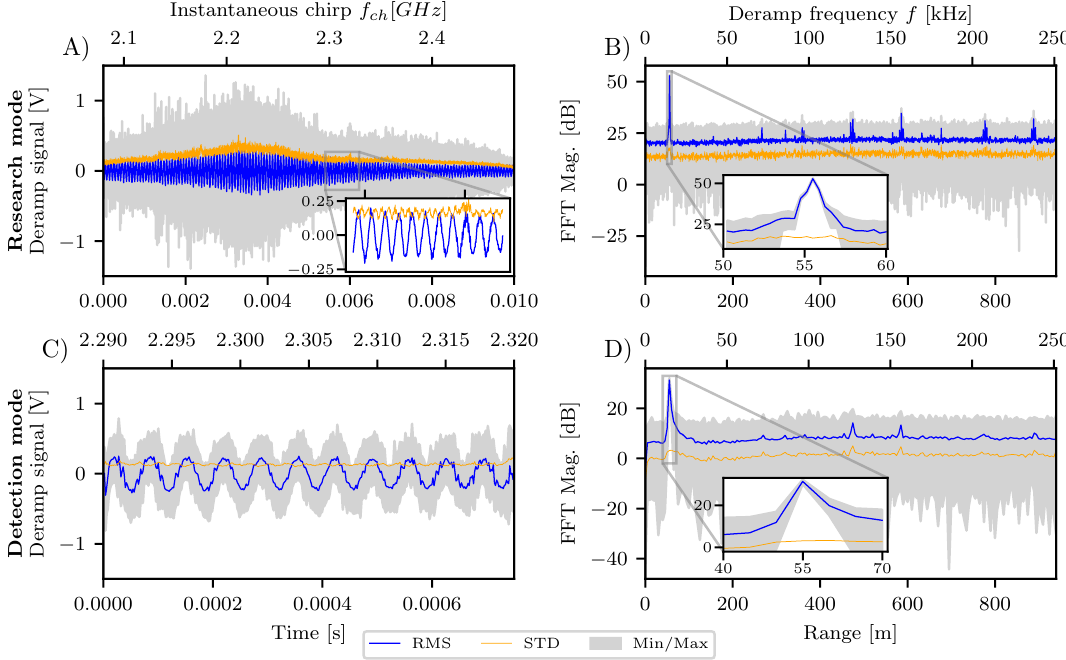
Figure 4. Deramp signal and spectrum statistics for both measuring modes with f lo = 8.12GHz. The research mode measurement is shown in the top row ( A , B ), the detection mode in the bottom row ( C , D ). The left panels show the data acquired with the ADC with the pulse duration time on the bottom axis and the corresponding instantaneous chirp frequency of the DDS f ch on the top axis. The right panels are the amplitude spectrum of the deramp signal f with bottom axis converted to radar